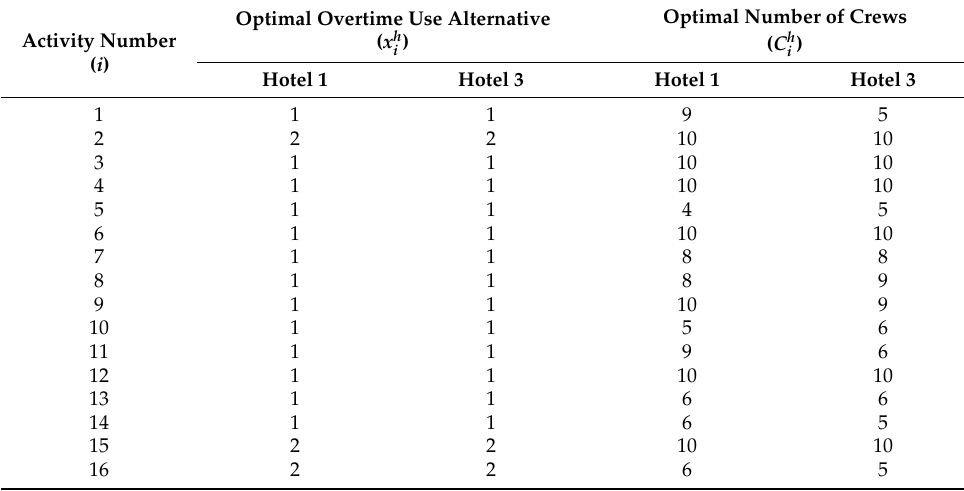
Table 9. Optimal overtime use and number of